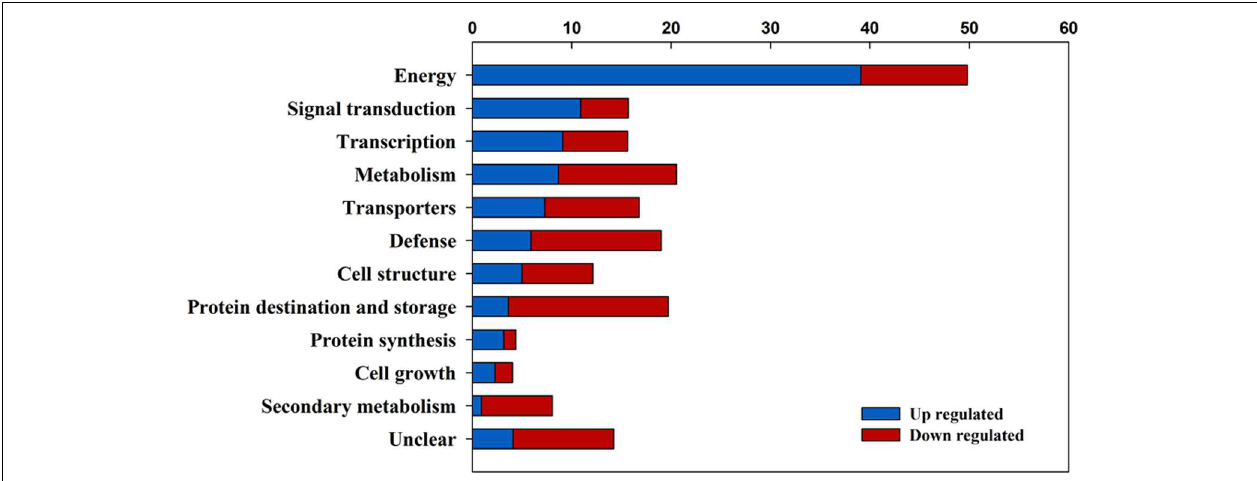
FIGURE 2 | The summarized gene ontology analysis of the differently expressed genes between progeny of primed plants (PH) and non-primed plants (NH) under heat stress during grain filling. The blue bars stand for the up-regulation of expressions of clustered genes in PH relative to NH; the red bars stand for the down-regulation of expressions of clustered genes in PH relative to